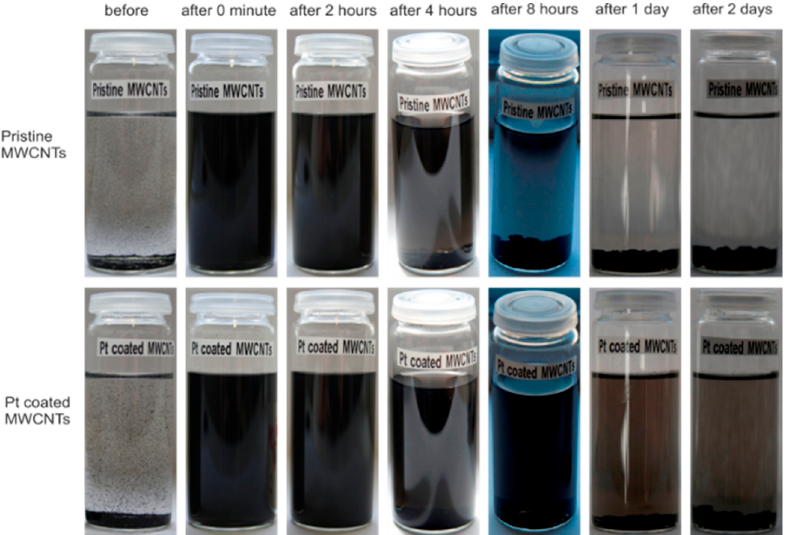
Figure 3. Dispersion ability and stability of Pt coated CNTs and pristine CNTs. Same weight (1.14 mg) of Pt coated CNT (coating ratio has been considered) and pristine CNTs in same amount of ethanol (20 mL). Sonicated for 15